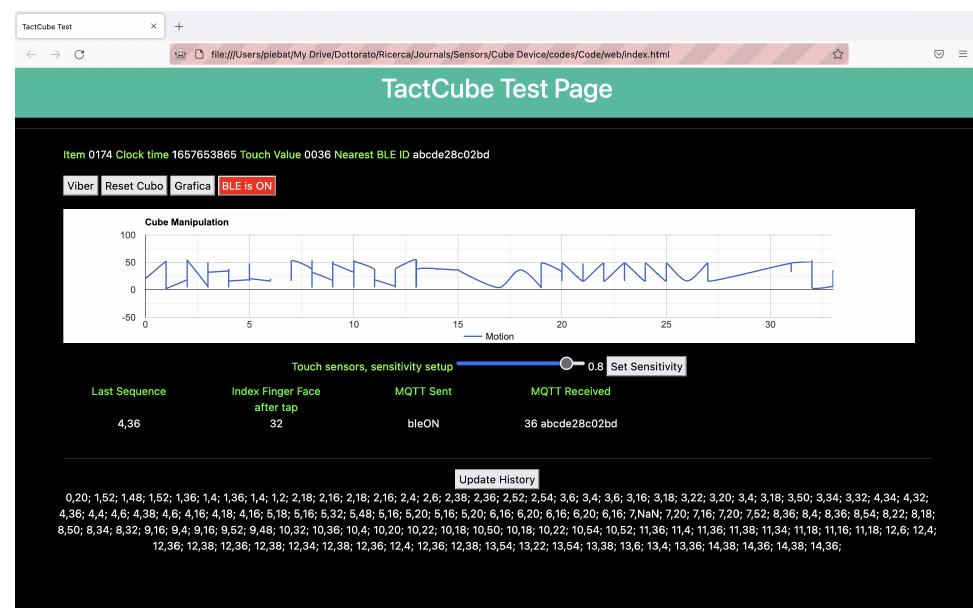
Figure 11. A screenshot from test